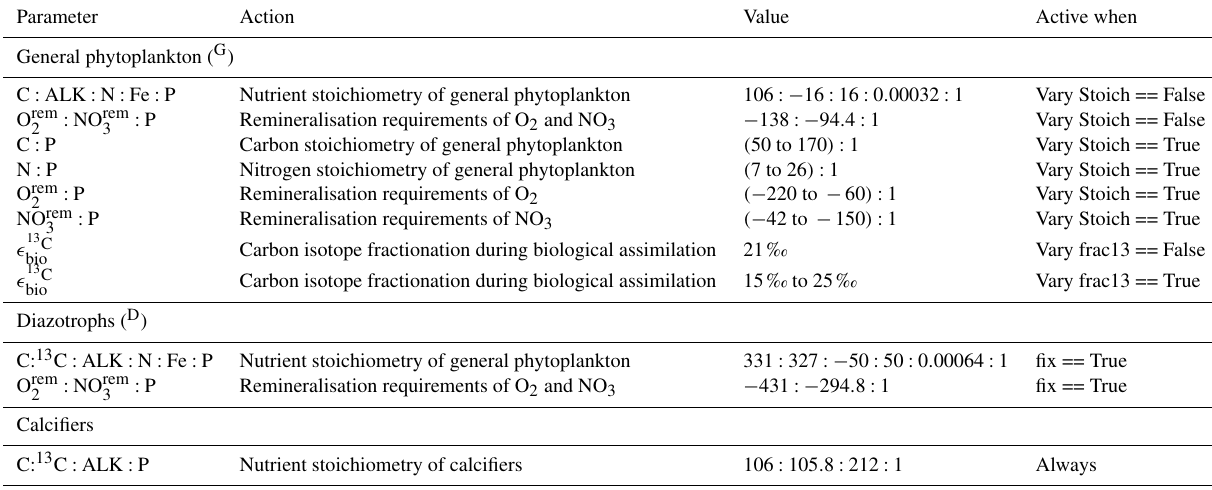
Table B3. Parameter values controlling stoichiometry in the ecosystem component of the CSIRO Mk3L-COAL ocean model. Default settings: Vary Stoich == True , Vary frac13 == False and fix == True .